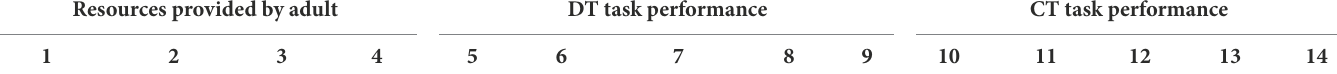
TABLE 6 Correlation analysis between resources provided by adults and children’s creativity performance (controlling for adults’ education